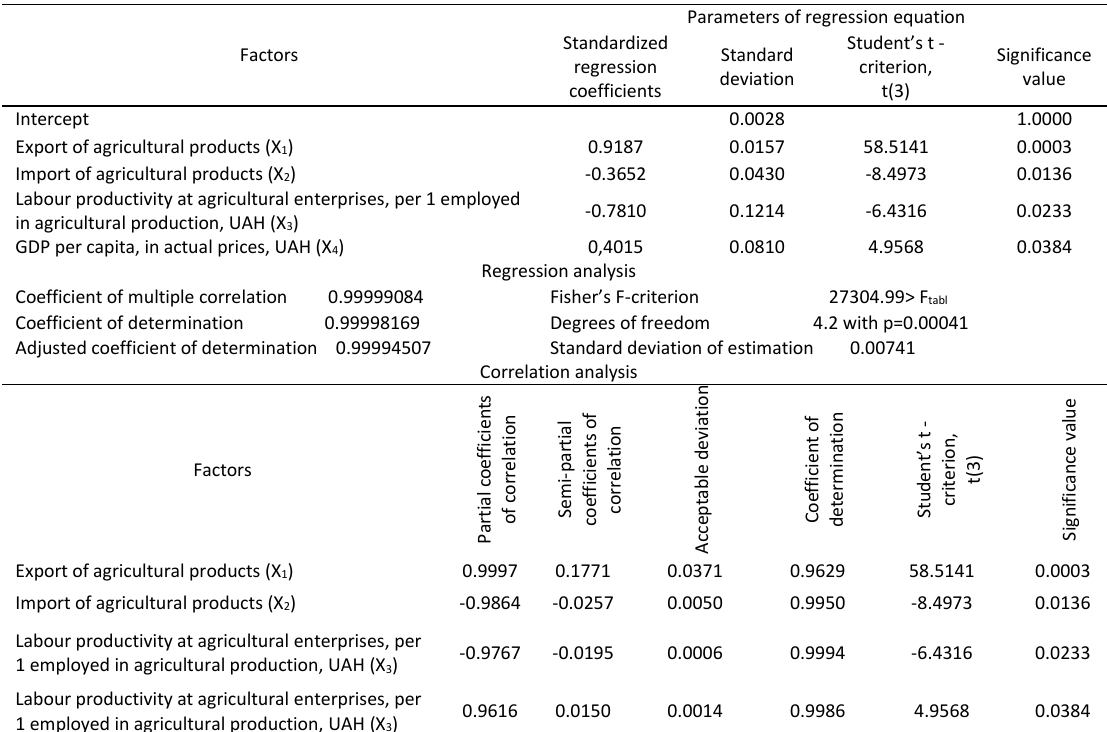
Table 9: Results of multiple regression model of the dependence of food provision at consumer market of Ukraine on economic factors (State Statistics Service of Ukraine, 2018b; State Statistics Service of Ukraine,